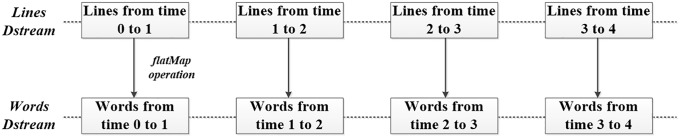
Spark flow data processing.